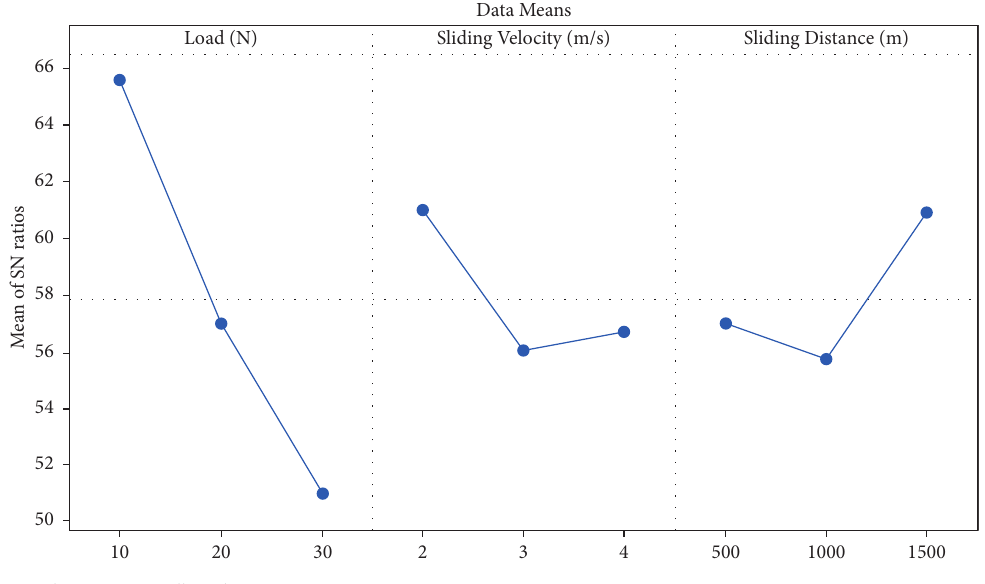
Figure 6: Main effects’ plot for the S-N ratio of wear loss.